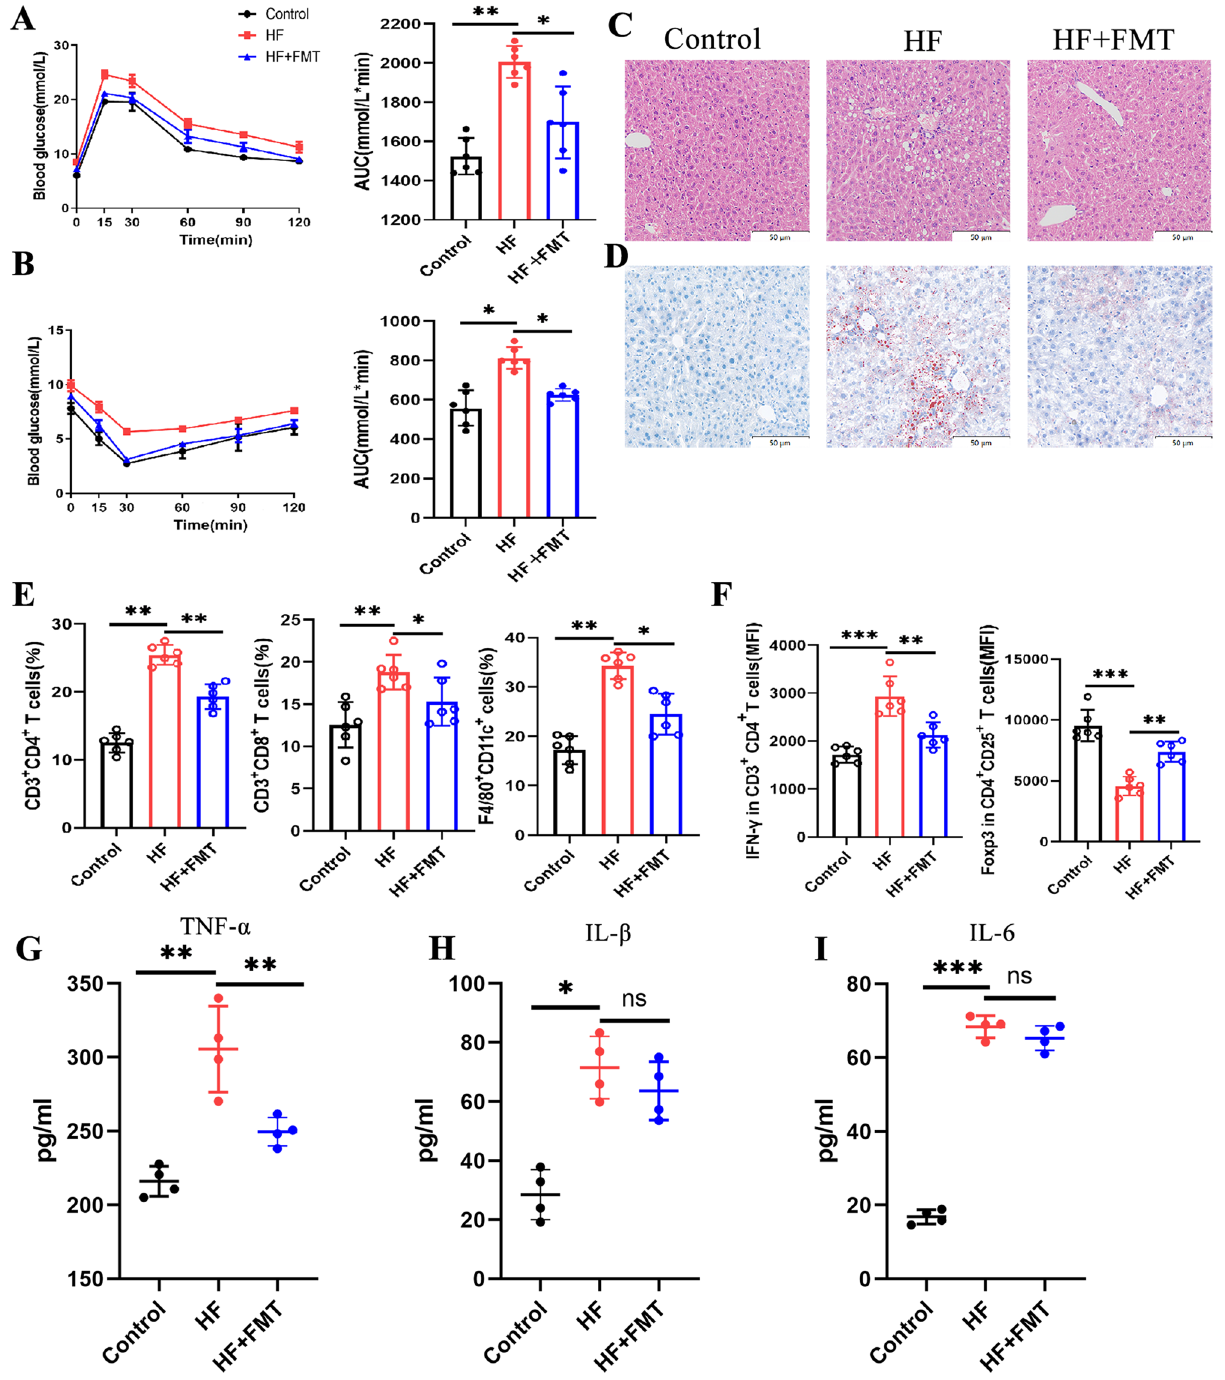
Figure 8. The effect of FMT on insulin resistance, liver histology, and immune homeostasis imbalance in HF-fed mice. ( A ) Glucose tolerance test (left) and glucose tolerance test calculated AUC (right) measured after FMT treatment. ( B ) Insulin tolerance test (left) and insulin tolerance test calculated AUC (right) measured after FMT treatment. Representative images of liver stained with ( C ) H&E and ( D ) Oil-red-O. Bar: 50 µm. ( E ) Flow cytometry analysis of CD3 + CD4 + T cells, CD3 + CD8 + T cells, and M1 macrophages (F4/80 + CD11c + ) in liver. ( F ) Flow cytometry analysis of the MFI expression level of Th1 cells (CD4 + IFN-γ + ) and Treg cells (CD25 + Foxp3 + ) in MLN. The levels of TNF-α ( G ), IL-1β ( H ) and IL-6 ( I ) in serum were determined using ELISA. One-way analysis of variance (ANOVA) test was used for determining statistical significance. * p < 0.05; ** p <